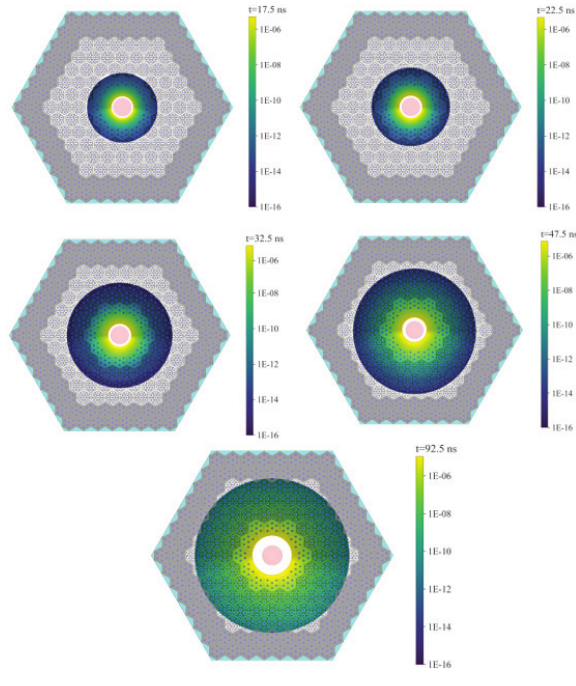
Figure 5. Power density dynamics in the fusion-fission facility.